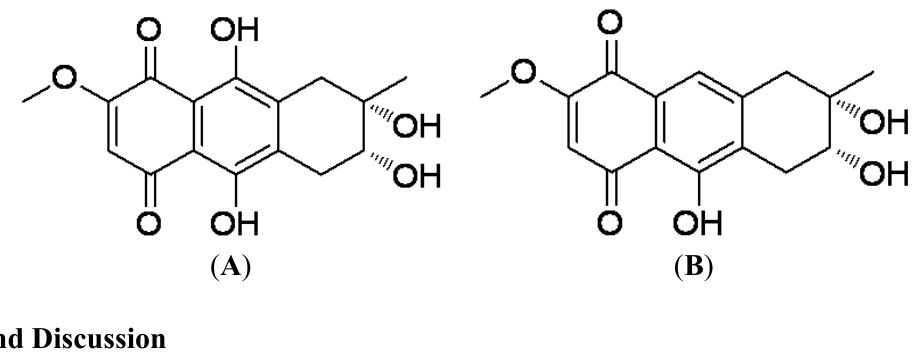
Figure 1. The structure of 4-deoxybostrycin ( A ) and nigrosporin ( B ).